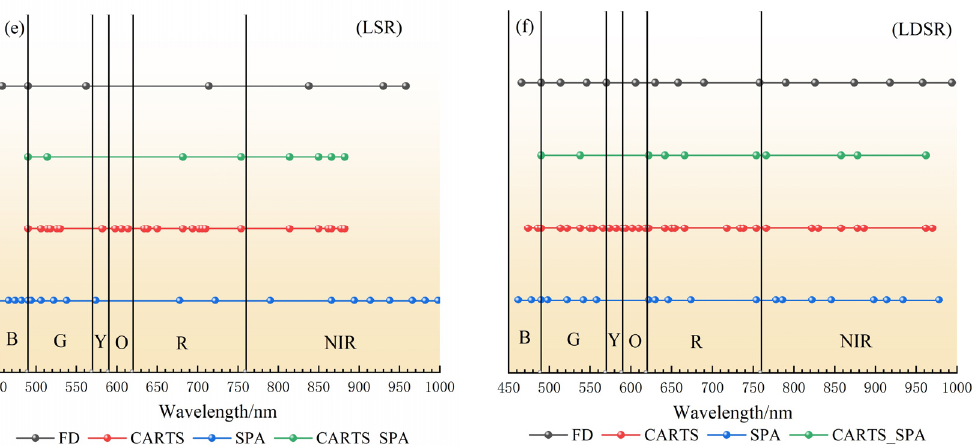
Figure 6. Distribution of feature band selection of feature extraction algorithms for different spectral transformations: ( a ) SSR, ( b ) DSR, ( c ) RSR, ( d ) RDSR, ( e ) LSR, ( f ) LDSR.